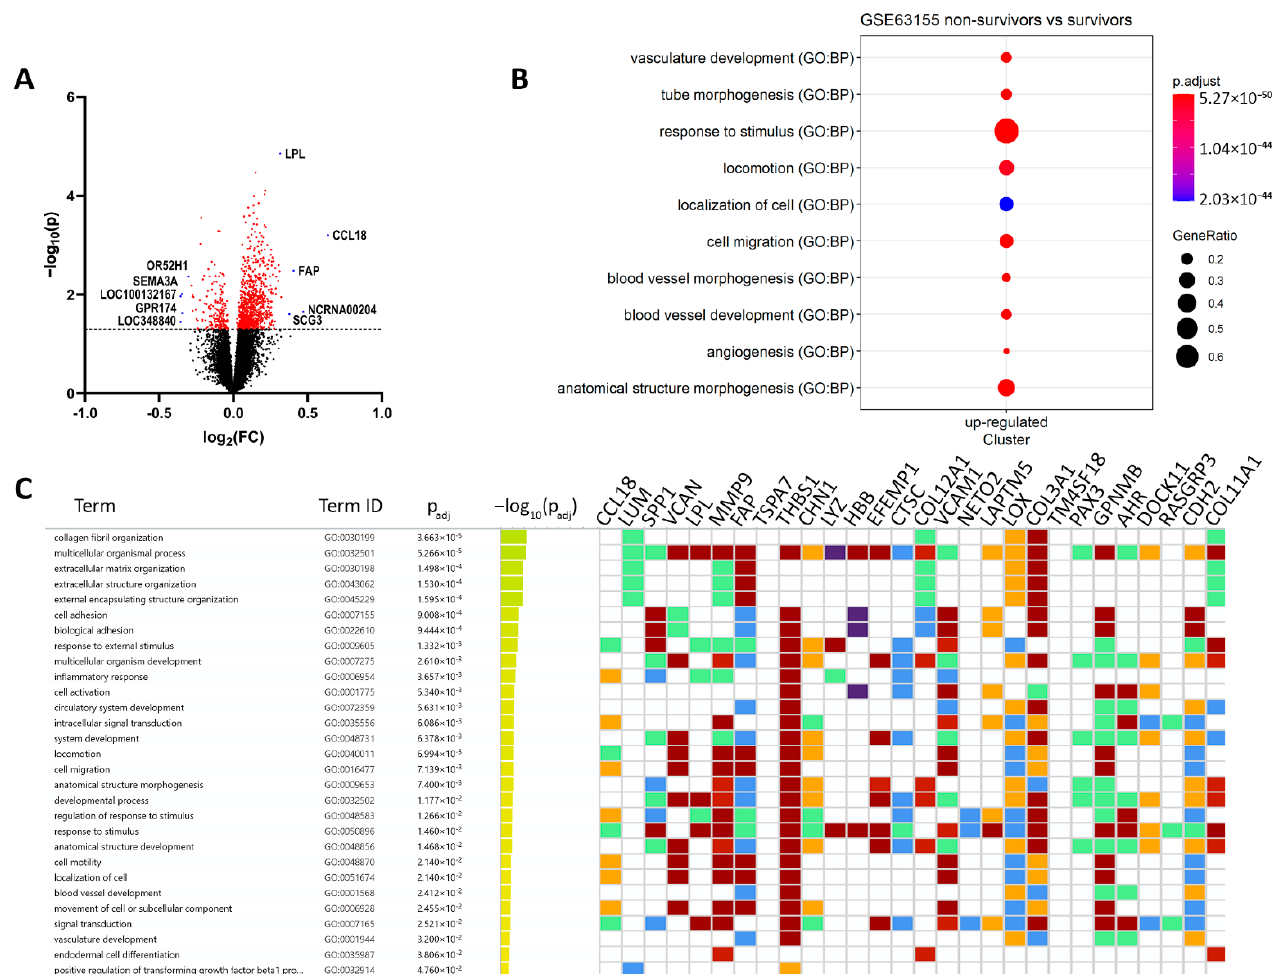
Figure 1. Differentially regulated genes (DEGs) in ES patients with various survival statuses. ( A ) Volcano plot diagram of differentially regulated genes in the tumor tissue from survivor ( n = 32) vs. nonsurvivor ( n = 14) patient samples (data were extracted from GSE63155). The data were extracted from GSE63155 and resulted in 1006 genes. Differentially regulated genes with p ≤ 0.05 are labeled red. The x -axis represents Log2 fold change; the y -axis represents negative log10-transformed p - values. Dots on the left side represent transcripts upregulated in survivors, and dots on the right side represent transcripts upregulated in non-survivors. Blue dots represent most and downregulated genes by log2fold change. ( B ) a GO analysis of DEGs associated with ES patient survival. The node sizes indicate gene counts enriched in the pathway and the color shows the p -value from low (red) to high (blue) level. Significance was set at p < 0.05. DEGs, differentially expressed genes; GO, gene ontology. The plot was created using the R gProfiler2. ( C ) Significant enrichment of molecular function of interacting proteins; gene-ontology-based GSEA analysis indicates the top 30 genes most expressed in non-survivor vs. survivor patient samples. The heatmap indicates a log2 fold change in mRNA expression. The colors for different evidence codes in the table: red: inferred from experiment, direct assay, mutant phenotype, genetic interaction, physical interaction; purple: inferred from experiment, direct assay, mutant phenotype, genetic interaction, physical interaction; green: traceable author, non-traceable author, inferred by a curator; orange: expression pattern, sequence or structural similarity, genomic context, sequence model, sequence alignment, sequence ontology, the biological aspect of the ancestor, rapid divergence; blue: reviewed computational analysis, electronic annotation.